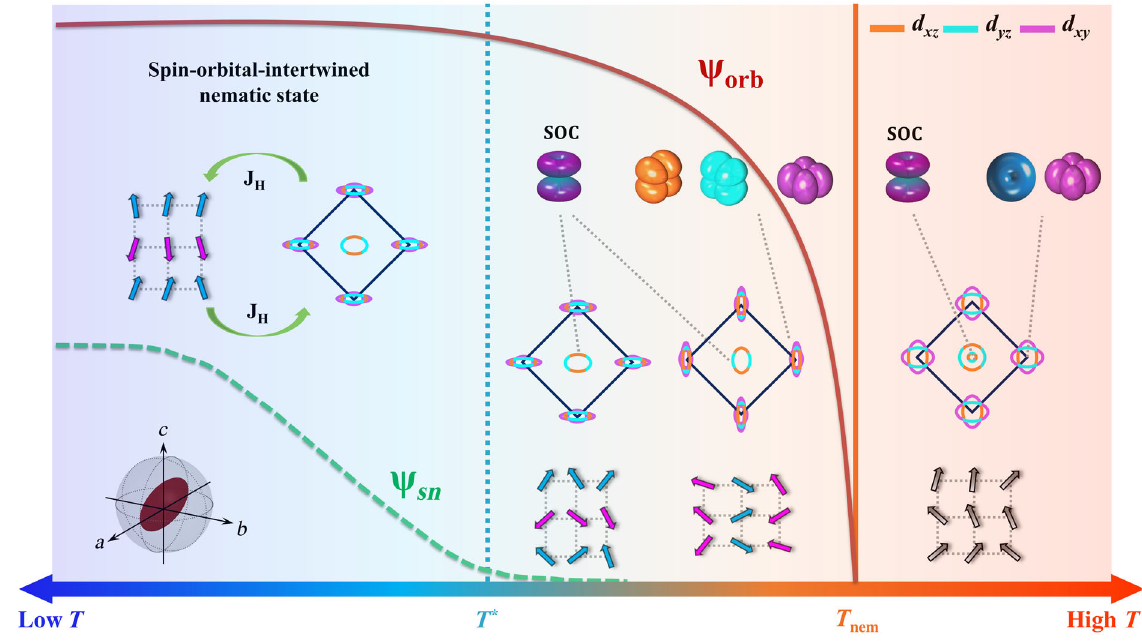
FIG. 5. A proposed physical scenario for the spin-orbital intertwined nematic state in FeSe. We adopt an empirical two-fluid model (a detailed description is presented in the main text) to explain our proposed scenario. The coherent part in this model contributes to the Fermi surface, which is related to itinerant spin d.o.f. The incoherent part in this model stands for the local-spin d.o.f. with a predominant 3 d ’ s coupling. Above T , the coupling between the local and itinerant spins is xy character. These two parts are coupled by Hund nem incoherent. A negligible SOC effect was verified by the recent INS experiments [13]. A nearly isotropic temperature-dependent bulk magnetic susceptibility is also confirmed, which is consistent with a negligible SOC effect (see Supplemental Material [39]). Below T , an orbital order driven by nematic transition emerges, and the corresponding temperature-dependent order parameter ( Ψ ) obeys nem orb a standard second-order phase transition. Such orbital order breaks the rotational symmetry of the lattice and leads to a simultaneous Fermi surface reconstruction. Considering a finite SOC, the spin d.o.f. should also break the rotational symmetry due to orbital order. In this case, if the spin susceptibility is dominated by the local spins, only a negligible in-plane anisotropy ( Ψ sn ) can be observed through local-spin susceptibility. However, a sizable in-plane anisotropy of spin susceptibility is verified by the NMR experiment in this research (ellipsoid with a long axis along the a and c crystallographic directions at the bottom-left inset), which is ascribed to an emergent coherent coupling between local and itinerant spins by Hund ’ s coupling below T . A remarkable change of Ψ sn only happens nem below T (cid:3) , which also proves that such sizable in-plane anisotropy is related not only to the orbital order but also to the Hund ’ s coupling- induced coherence. For more details, see the main